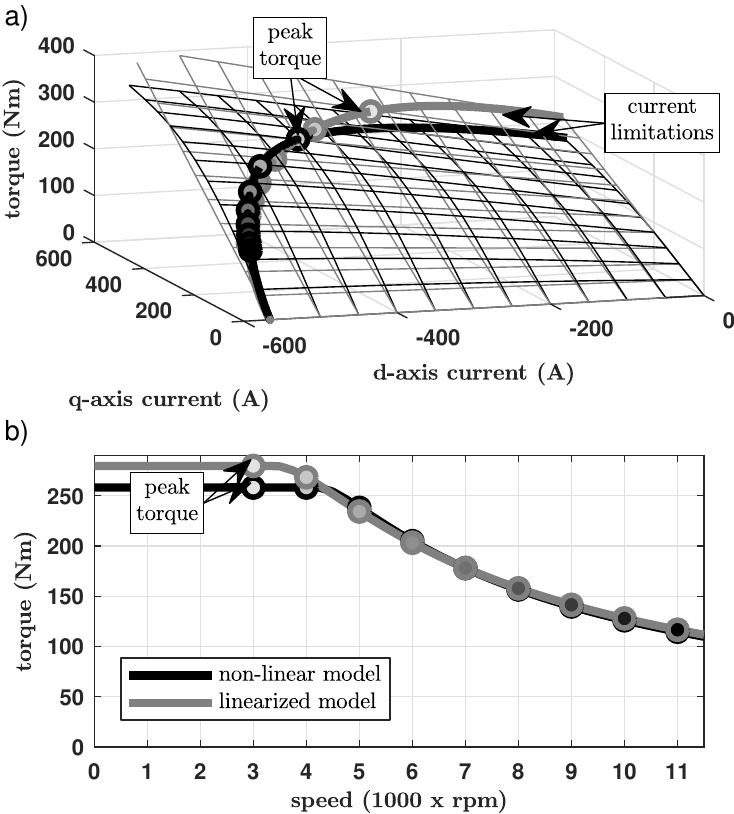
Figure 9. Comparison of the maximal BMW i3 traction drive torque calculated with two different methods, i.e., the numerical search algorithm based on the non-linear machine model (black) and analytical equations based on the linearized machine model (gray): ( a ) torque surfaces, ( b ) torque vs. speed curves. The filled dots are the operation points for different